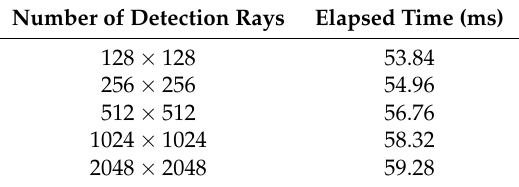
Table 2. Time consumed by an iteration with different number of detection rays. The number of SMPL models is 1.